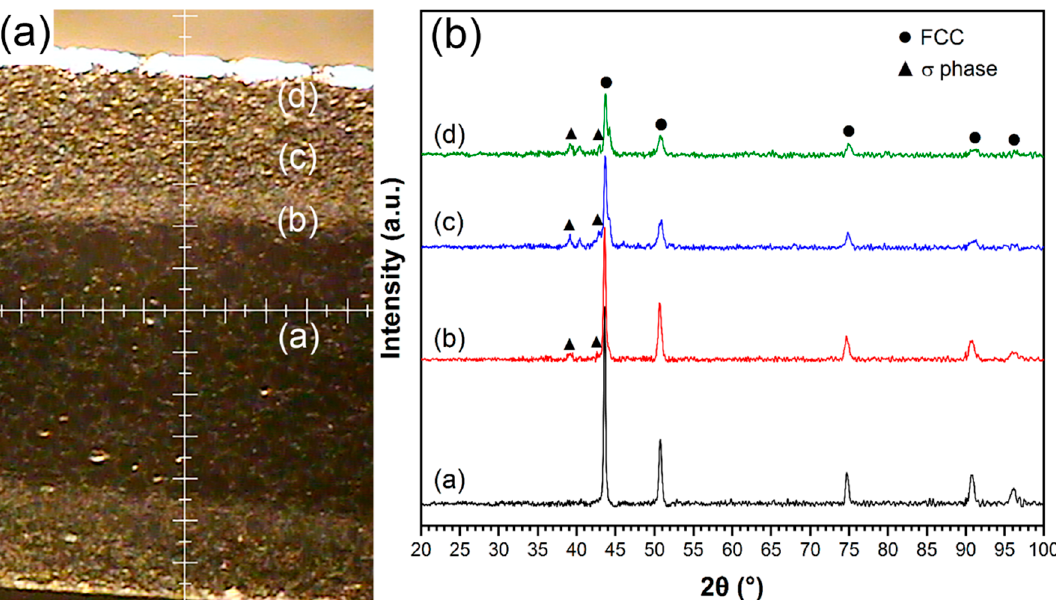
Figure 5. XRD pattern of different areas in the sample of HEA after SPS at 1150 ◦ C and 30 MPa, ( a ) the macrostrucutre of the 30 MPa sintered sample, and ( b ) XRD pattern of the corresponding position in ( a ). Table 1. Chemical composition of FeCoCrNiMo after spark plasma sintering (SPS) at 1150 ◦ C and 30 MPa. FCC—face-centered cubic. Chemical Composition (at.